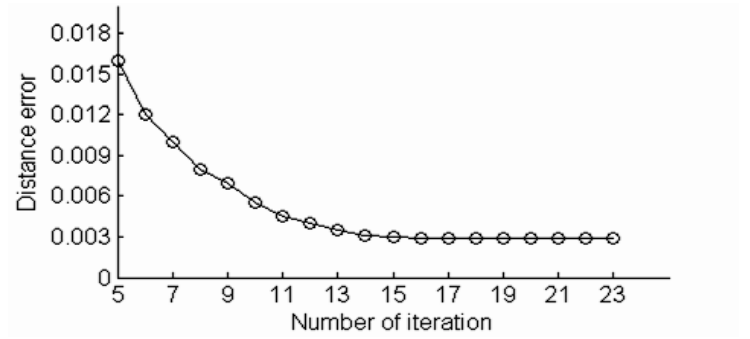
Figure 15. Relation between distance error and the number of iteration.